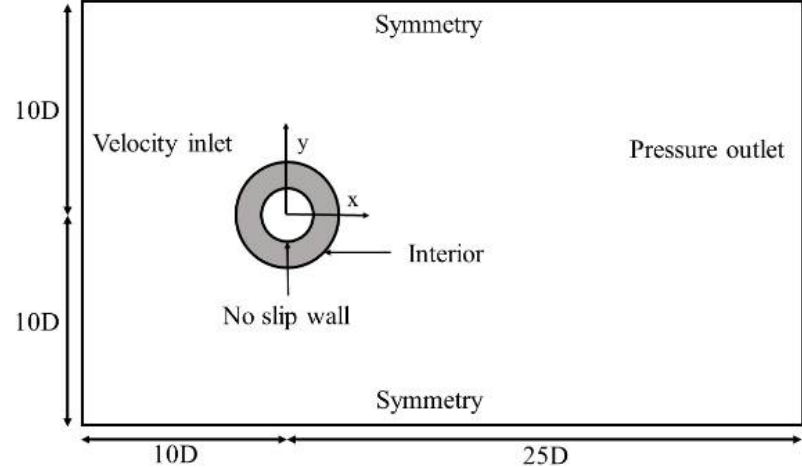
Figure 4. Sketch of the computational domain.